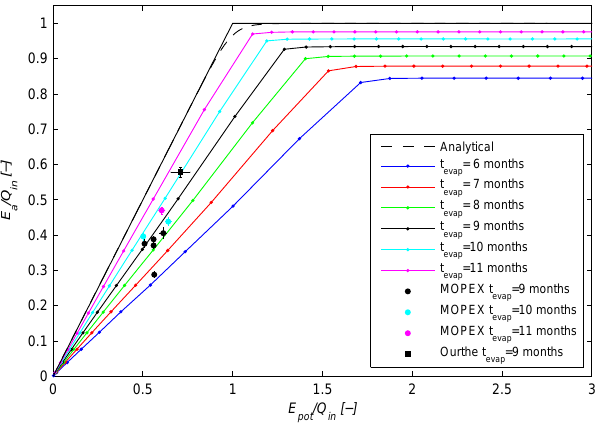
Figure 4. Sensitivity to on–off dynamics in actual evaporation in the forward model. MOPEX catchments were filtered to have only those catchments having a coefficient of variance < 0 . 12 for monthly median rainfall and with at least 1 month with a median maximum air temperature < 0 ◦ C; a month is considered to have no actual evaporation if the monthly median maximum air temperature < 0 ◦ C (after Devlin, 1975). Error bars indicate 1 standard deviation and are determined with bootstrap